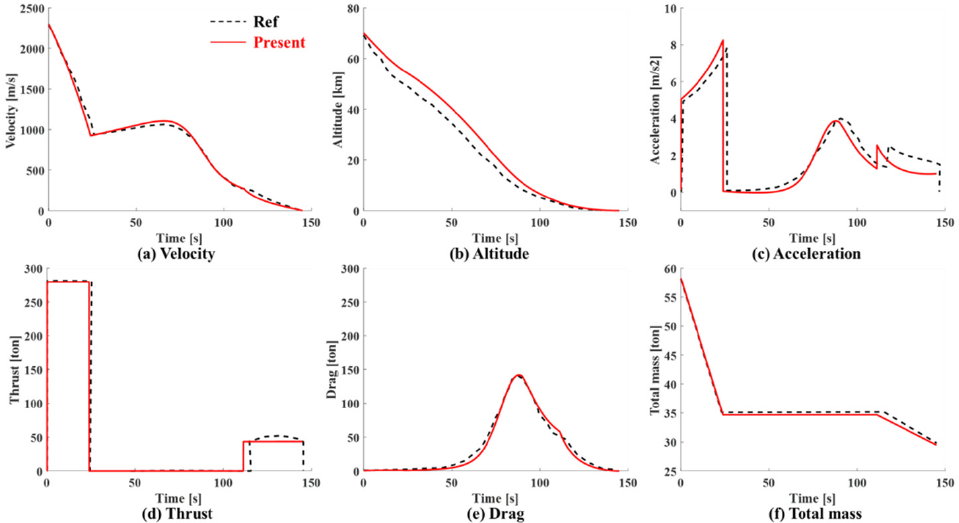
Figure 15. Validation of trajectory data obtained from a previous study [22]. ( a ) Velocity; ( b ) Altitude; ( c ) Acceleartion rate; ( d ) Thrust; ( e ) Drag; ( f ) Total mass.